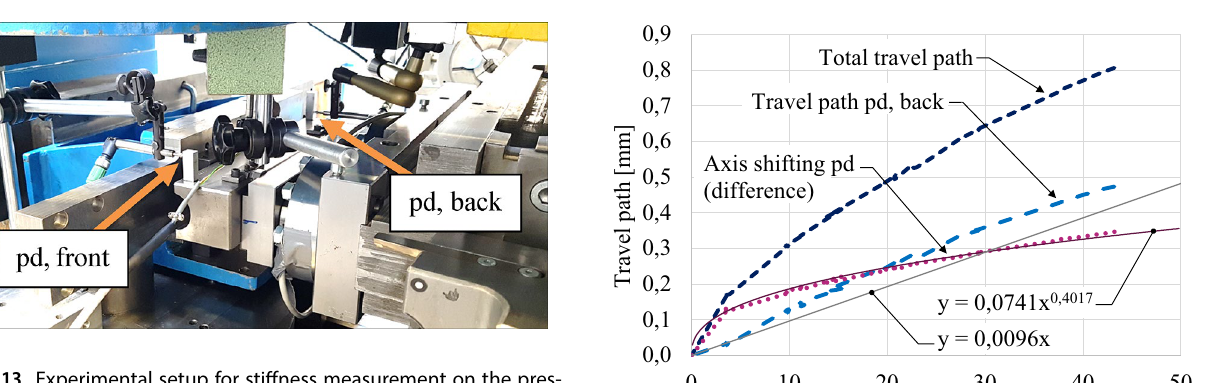
Fig. 13 Experimental setup for stiffness measurement on the pres- sure die axis